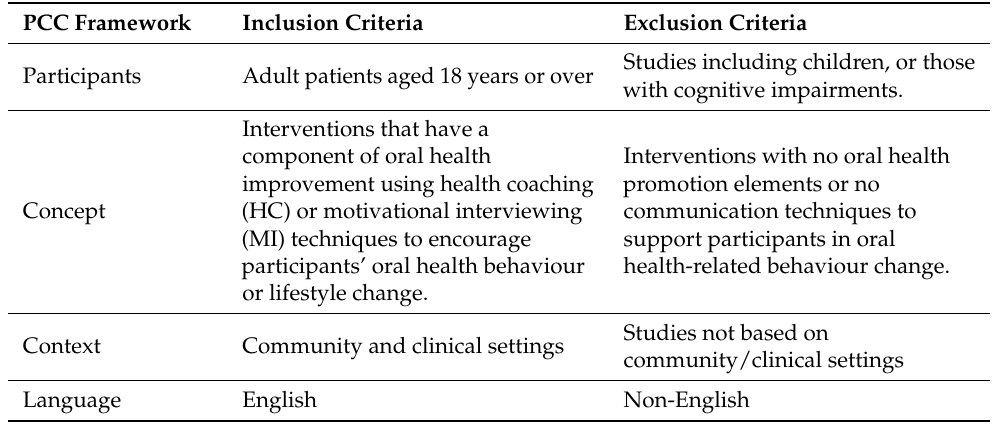
Table 1. A summary of eligibility